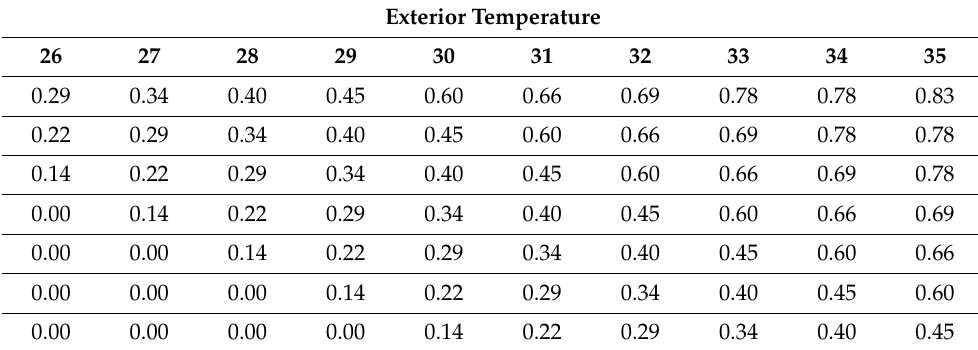
Table 3. Average power of polymeric air-conditioning unit at different outdoor temperatures (kW). Exterior